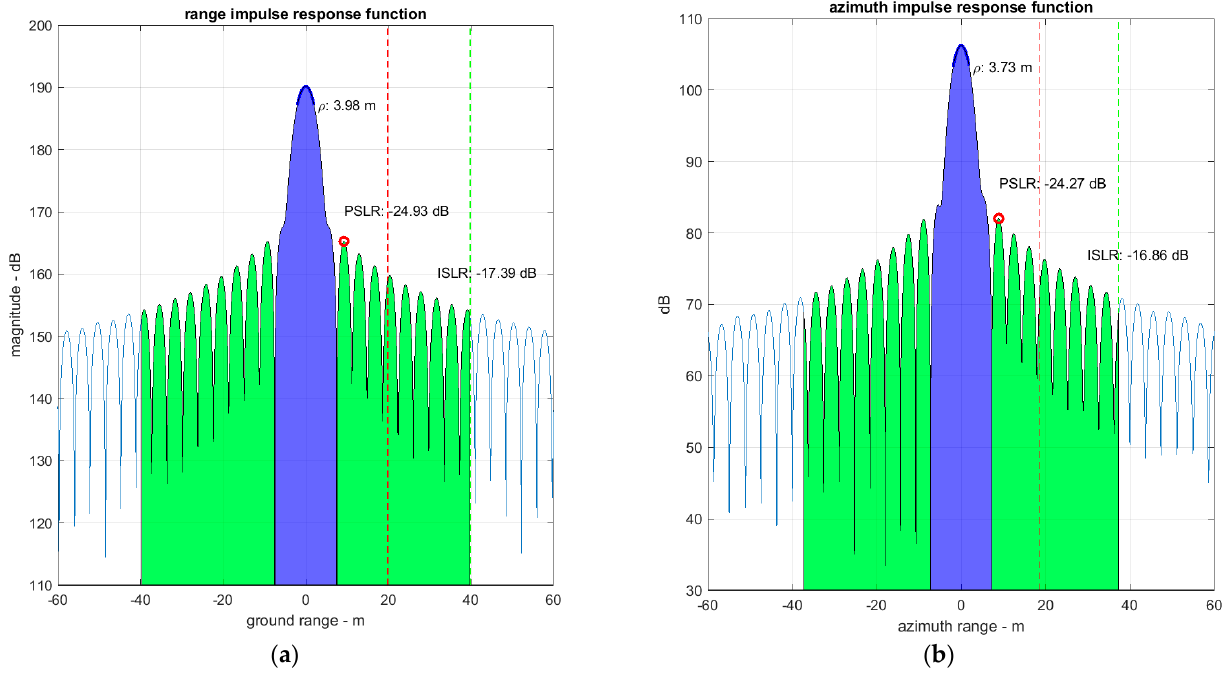
Figure 26. Impulse response function analysis in the ( a ) range and ( b ) azimuth of the S-STEP SAR payload in the wide-swath mode. The red circles indicate the peak side lobes.